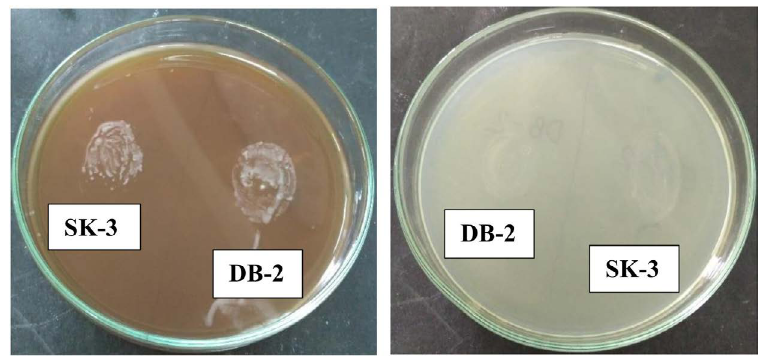
Fig. 7. Gelatinase and Lipase activity of L. plantarum DB-2 and SK-3